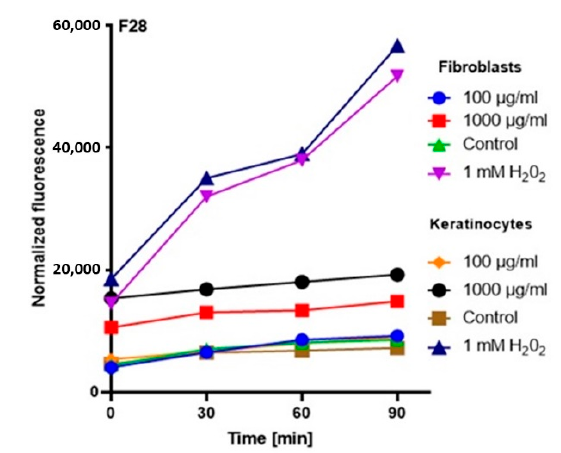
Figure 5. The effect of kombucha ferments’ extracts (F14) on the DCF fluorescence in fibroblasts and HaCaT cells. The data are expressed as the mean ± SD of 3 independent experiments, each of which consisted of 3 replicates per treatment group.